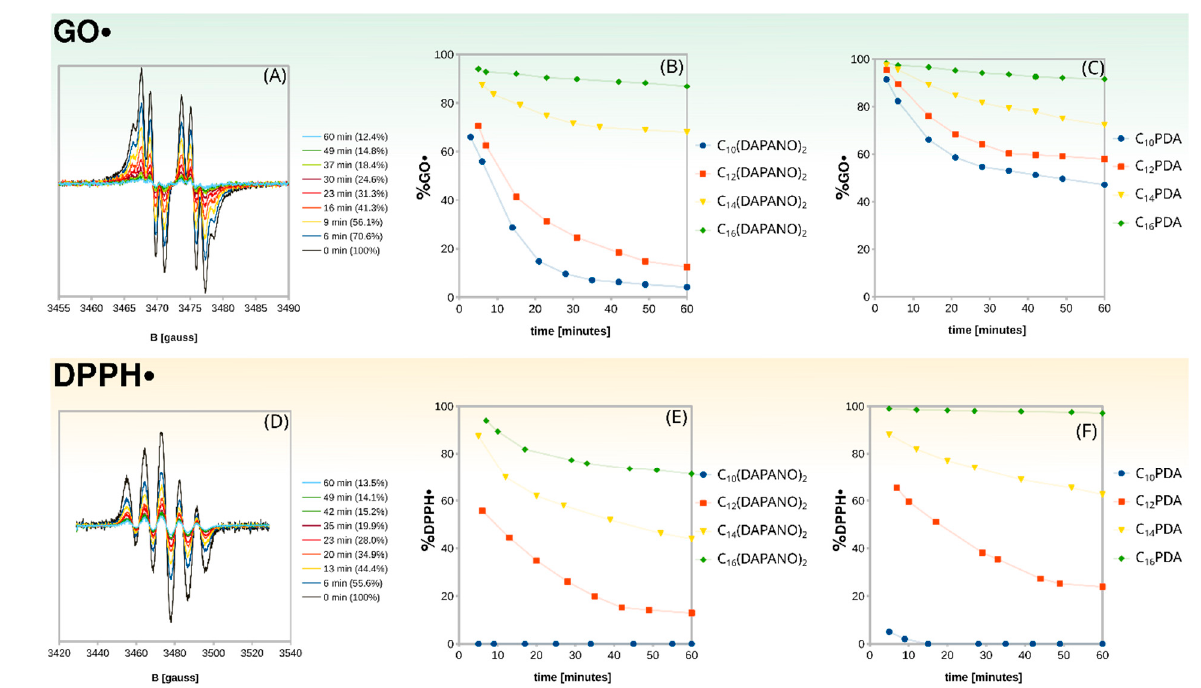
Figure 3. The scavenging activity of C n (DAPANO) 2 and C n PDA monitored with EPR spectroscopy: changes in the GO• absorption due to its reaction with C 12 (DAPANO) 2 ( A ); changes in the GO• concentration due to its reaction with C n (DAPANO) 2 and C n PDA [( B ) and ( C ), respectively]; changes in the DPPH• absorption due to its reaction with C 12 (DAPANO) 2 ( D ); changes in the DPPH• concentration due to its reaction with C n (DAPANO) 2 and C n PDA [( E ) and ( F ), respectively].